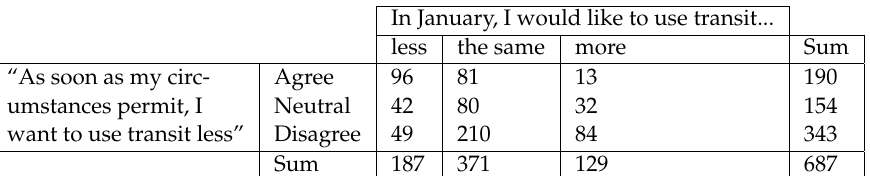
Table 2. Cross-tabulation of two questions regarding cessation of transit use. In January, I would like to use